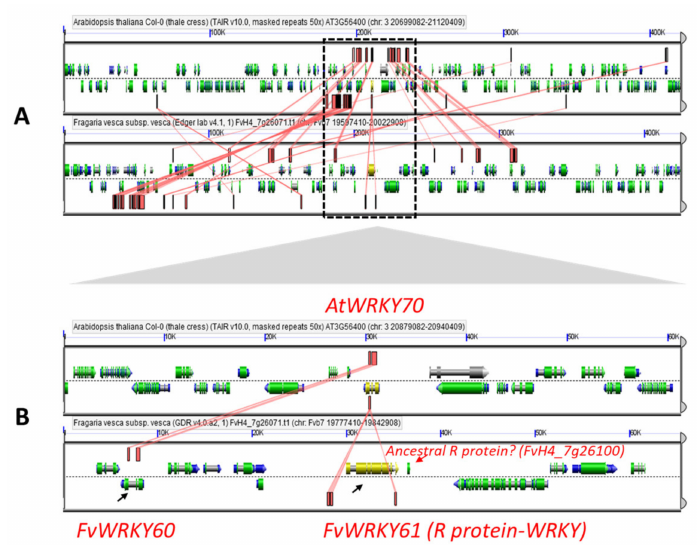
Figure 3. GEvo analyses comparing microsynteny between genomic regions from A. thaliana and F. vesca . ( A ) Genomic regions containing the genes FvWRKY60 , FvWRKY61 and AtWRKY70 with red blocks and connectors show high-scoring sequence pairs between both sequences. The region shown in B is framed. ( B ) Homology details among FvWRKY60 , FvWRKY61 (black arrows) and AtWRKY70 . A short, non- WRKY gene ( FvH4_7g26100 , red arrow) was identified as part of the FvWRKY59-60-61 tandem (see text for